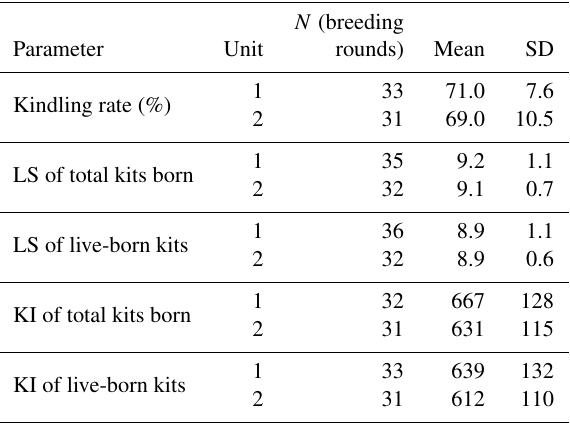
Table 2. Reproductive parameters with respect to housing unit for does with kits.